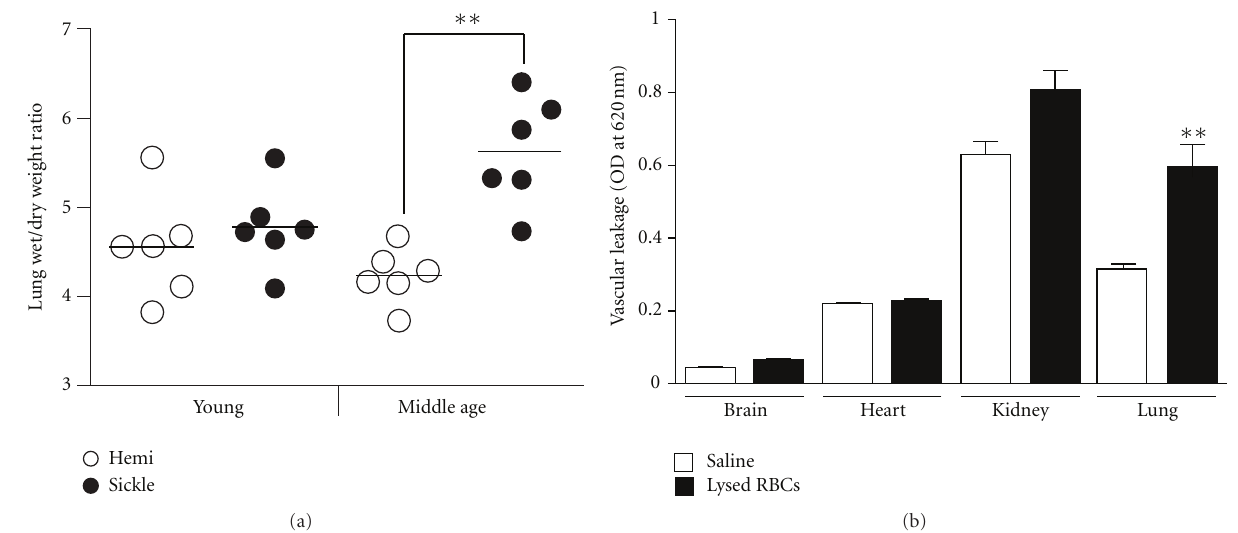
Figure 2: Chronic and acute changes in vascular permeability in sickle mouse lungs. (a) Lung edema in middle-aged Berkeley sickle mice as determined by wet/dry weight ratios ( n = 6). Control groups include young sickle mice ( n = 6) and young ( n = 6) and middle-aged ( n = 6) hemizygotes. (b) Vascular leakage in the indicated organs in Berkeley sickle mice intravenously injected with lysed red blood cells. Note that permeability is significantly increased by lysed red blood cells in the lung but not in other organs. ∗∗ P < 0 .